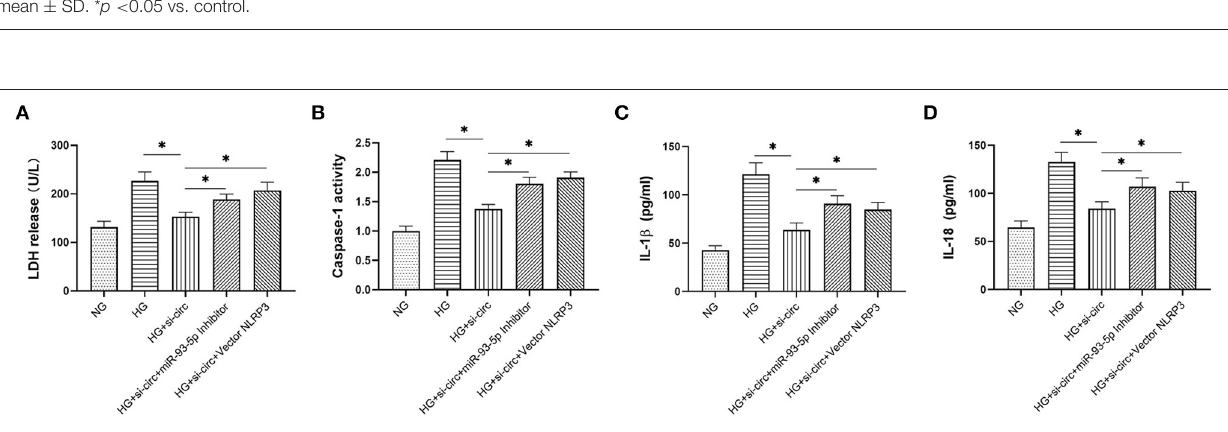
Renal tubular damage in DKD mainly includes apoptosis, EMT, and inflammatory cell infiltration around the